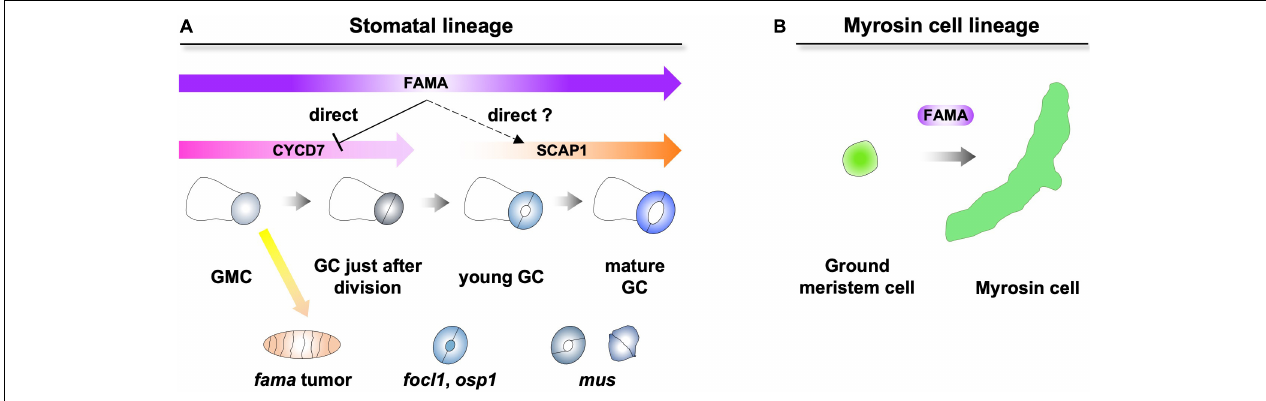
FIGURE 1 | Dual role of FAMA in epidermis and inner tissues. (A) FAMA regulates the final division of guard mother cells (GMCs) and the differentiation of guard cells (GCs). FAMA directly represses the expression of CYCD7 and potentially regulates the expression of SCAP1 . Loss of FAMA triggers the ectopic divisions of GMCs, resulting in the formation of fama tumors. In focl1 and osp1 , the pores of stomata are covered by membranous cuticular material. mus exhibits skewed GC (left) and unopen GC (right). (B) FAMA regulates the differentiation of ground meristem cells into myrosin cells in inner tissues.